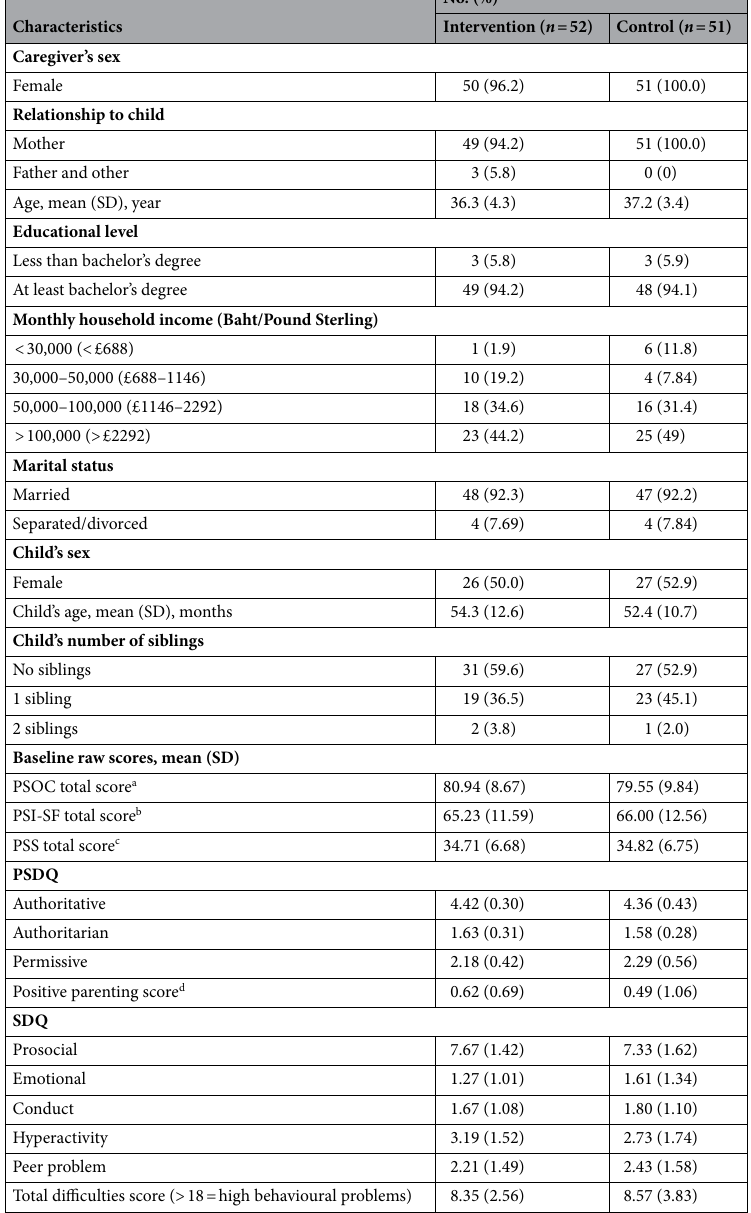
Table 2. Demographic characteristics of participants. SD standard deviation, PSDQ Parenting Styles and Dimensions Questionnaire, SDQ Strengths and Difficulties Questionnaire. a PSOC the Parenting Sense of Competence Scale total score: high scores = high sense of parenting competence. b PSI-SF Parenting Stress Index – Short Form total score: ≥ 86 = severe parenting stress. c PSS Parental Stress Scale total score: